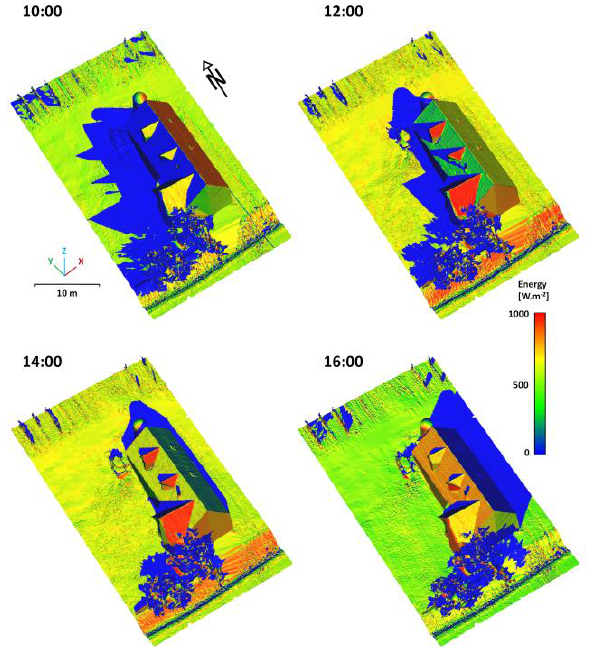
Figure 5. Solar radiation modelling for 15 September at 12 o'clock using 3D TIN model derived from (A) CRP, (B) ALS, (C) TLS Figure 7. Irradiation calculation for July 15 for a time period from 08:00 to 3.3 Calculate irradiance/irradiation for user-defined time/time period The proposed algorithm for the v3.sun module works similarly to module v.sun (Hofierka and Zlocha, 2004) and r.sun (Šúri and Hofierka, 2004) in two modes.